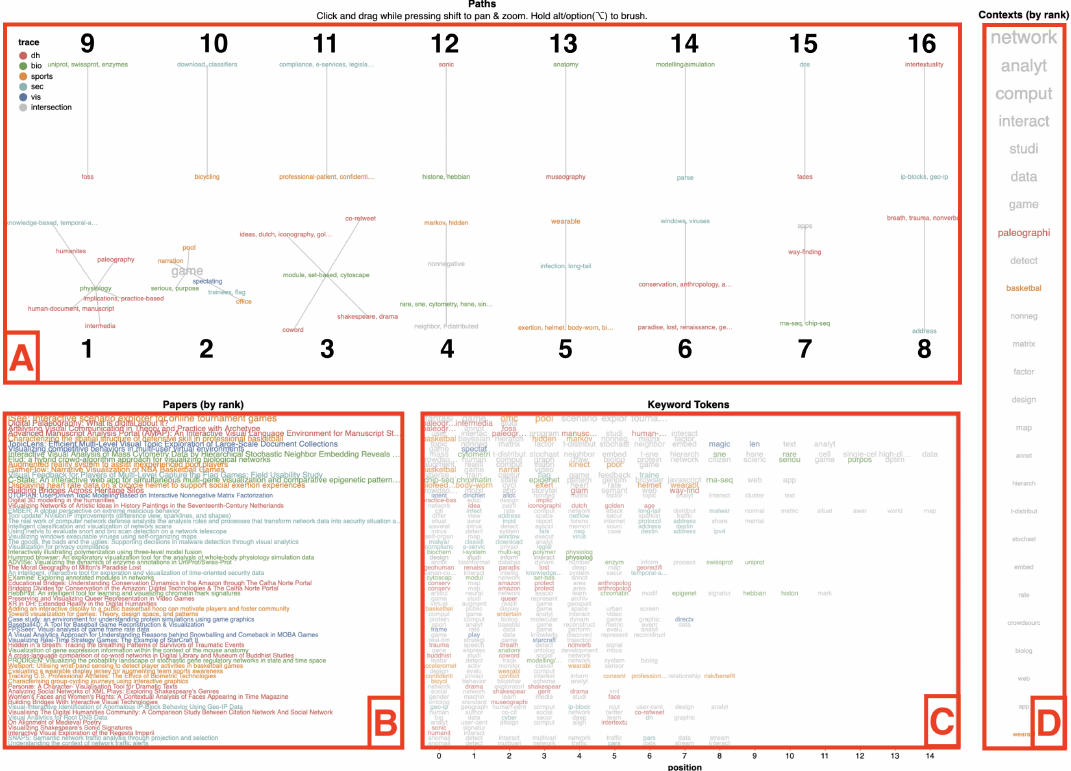
Figure 9. Screen capture of GlassViz showing the 16 components (view A ) extracted in the previous stage Section 4.4 and related documents (view B ), along with their keyword tokens (view C ) and co-occurring terms with nodes on each component (contexts, view D ). We encourage readers to download the high-resolution images companion to this paper which can be zoomed and explored to get a better understanding of how GlassViz